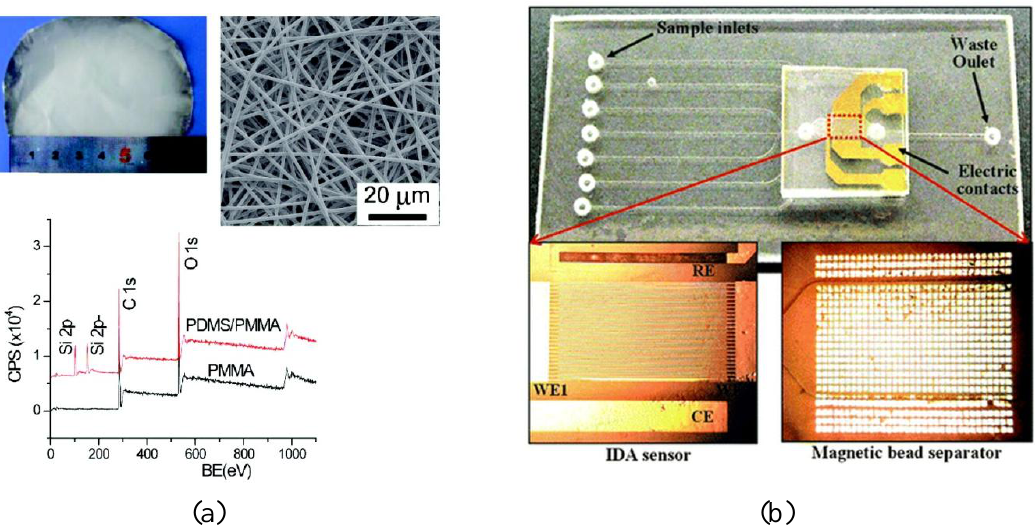
Figure 3. More examples of functional polymers; ( a ) electrospun polydimethylsiloxane (PDMS)/polymethylmethacrylate (PMMA) nanofibers and ( b ) an integrated immunoassay device on cyclic olefin copolymer. Adapted with permission from [86] and